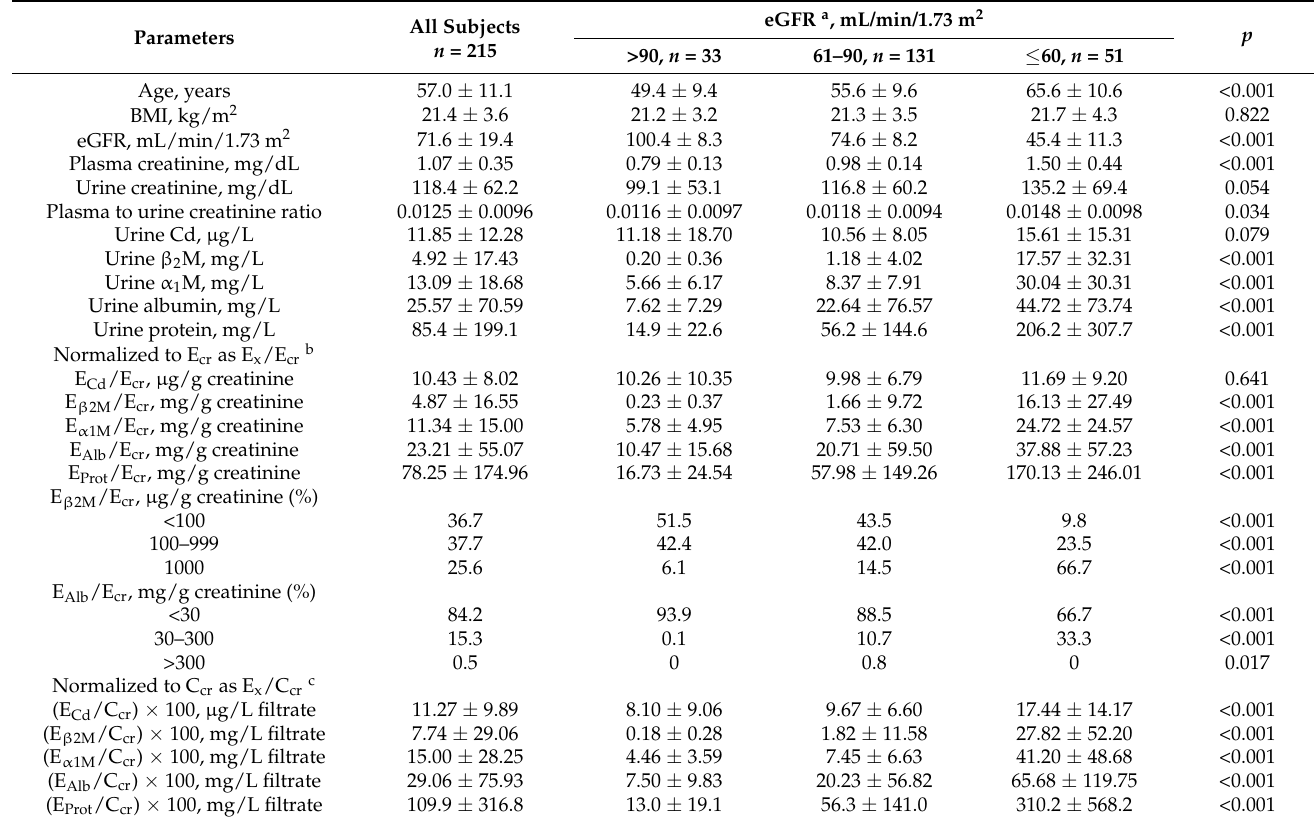
Table 5. Comparing excretion rates of various proteins and cadmium in the high-exposure group stratified by eGFR